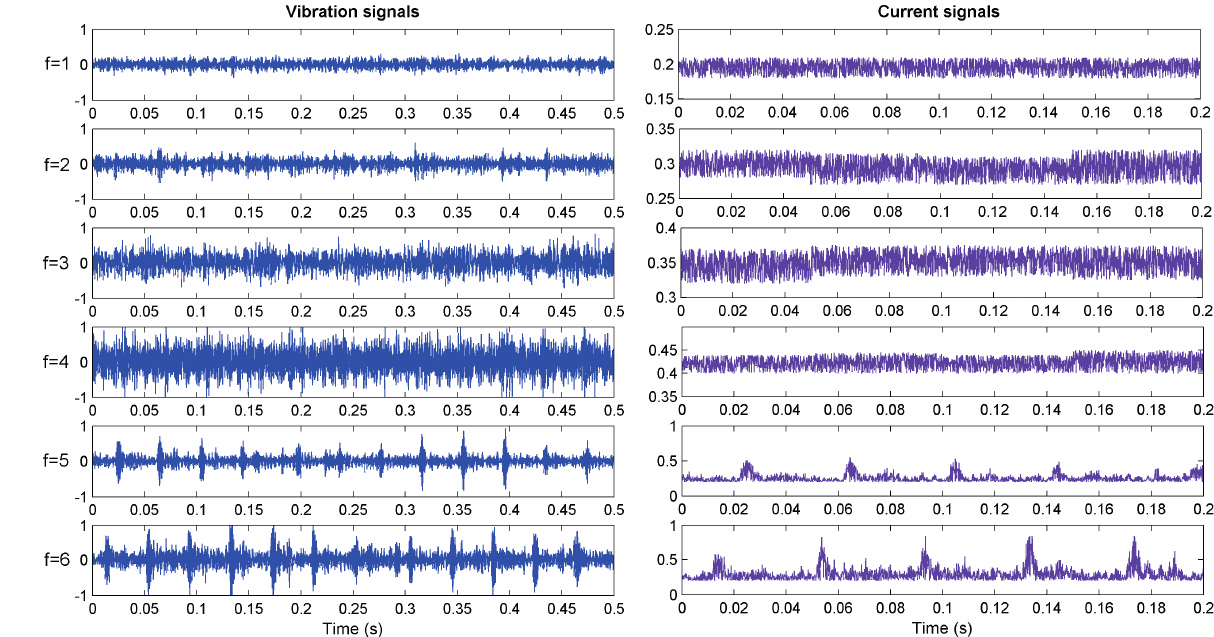
Figure 4. Measured signals from sensor ② and ⑤ in different